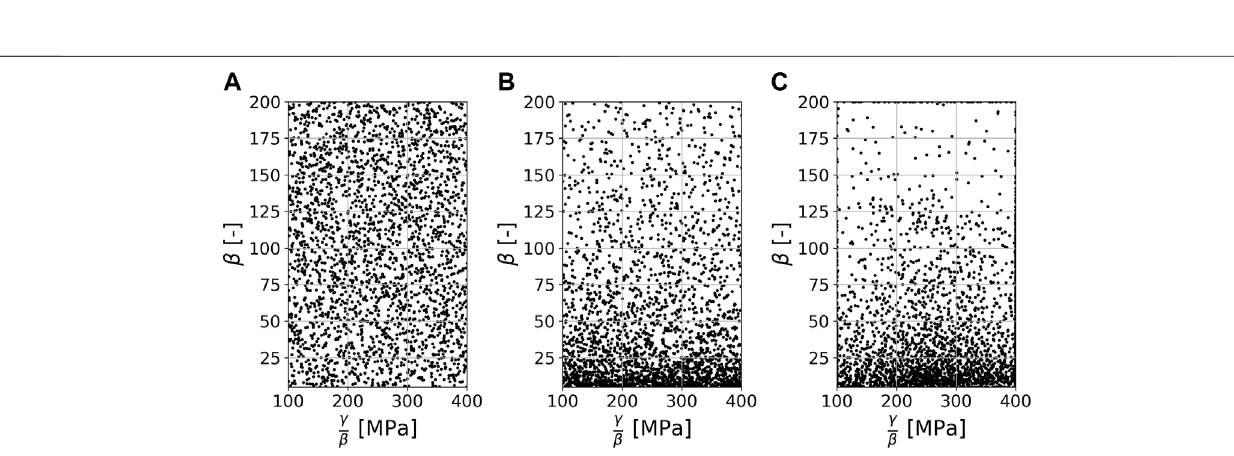
Frontiers in Materials |